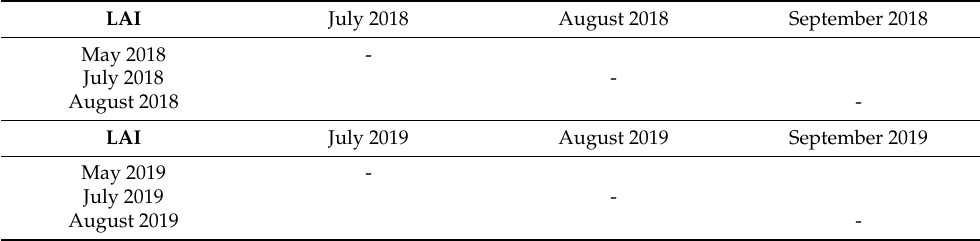
Table A3. Kruskal–Wallis test results for LAI between adjacent image acquisitions dates. The presence of *** denotes that the null hypothesis was rejected and that the samples are significantly different at p = 0.05